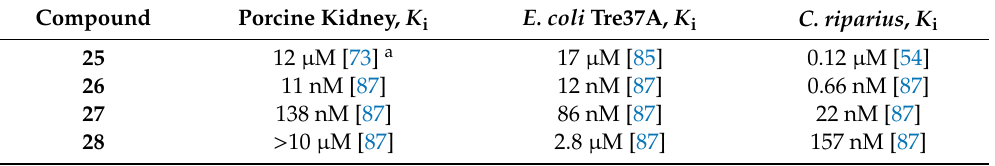
Table 3. Inhibition of porcine kidney, Tre37A and C. riparius trehalases by compounds 25 , 26 , 27 , and 28